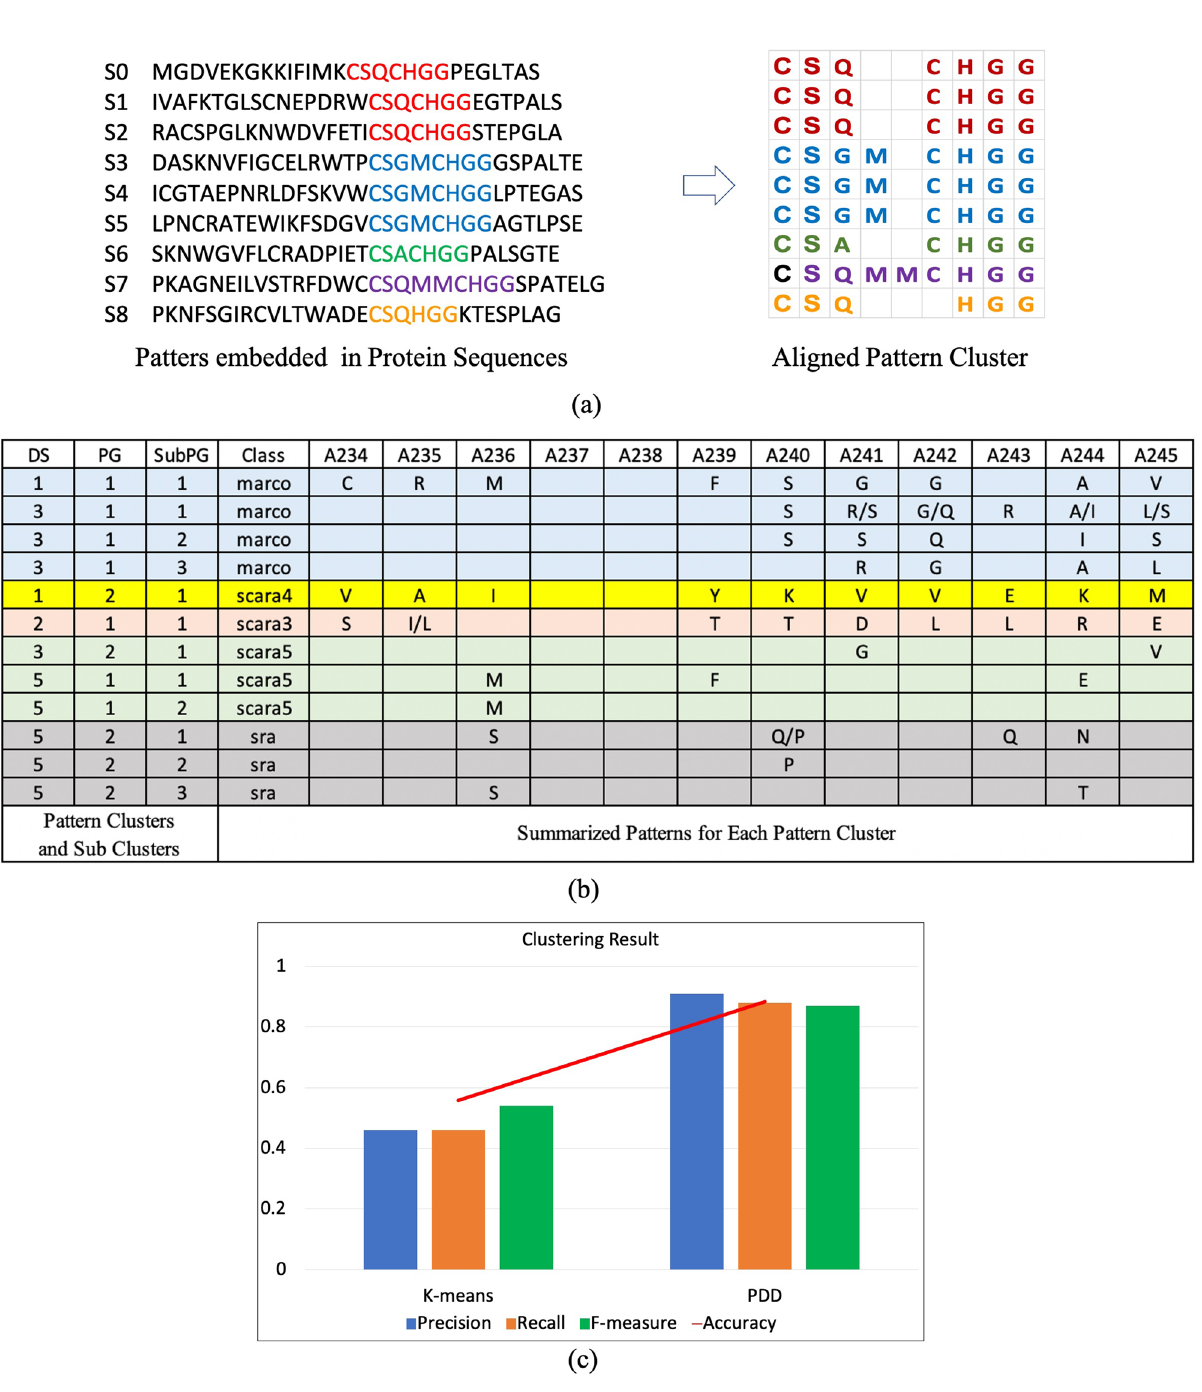
Figure 3. Result of pattern clustering and entity clustering on an APC representing a functional region of a protein family. ( a ) An APC obtained from a protein family. ( b ) Pattern clusters from an APC of Class A Scavenger Receptors. Patterns shown in different color shades are associated with 5 distinct classes. While K-Means could not separate Marco from Scara5 and Sra in the collagenous domain, PDD separated Marco from Scara5 in DS3 (DSU[5 1 1] and DSU[5 2 1] respectively). ( c ) Clustering scores of PDD and K-Means. PDD results are far superior to those of